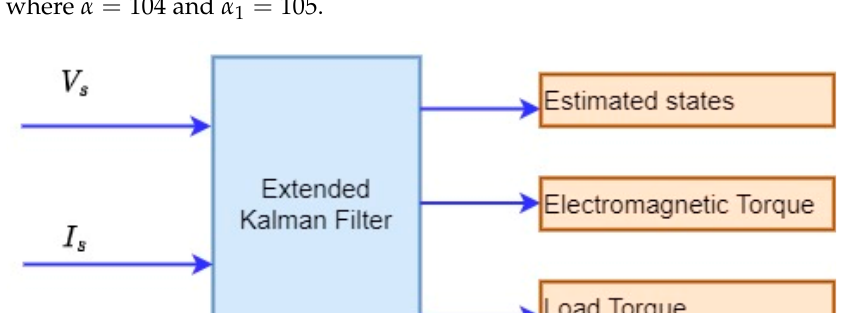
where α = 104 and α 1 = 105.